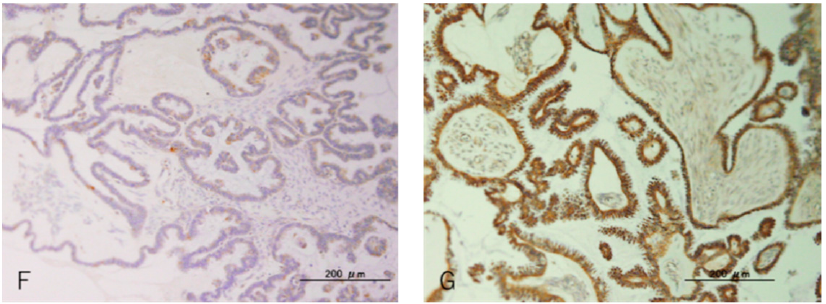
Figure 3. Representative immunohistochemical staining of ARID1A, PTEN, p53 and ERBB2 in SMBTs. Normal ( A ) and loss of ARID1A expression ( B ). Normal PTEN ( C ); overexpression ( D ) and loss of p53 expression ( E ); low ( F ) and overexpression ( G ) of ERBB2 in SMBTs.